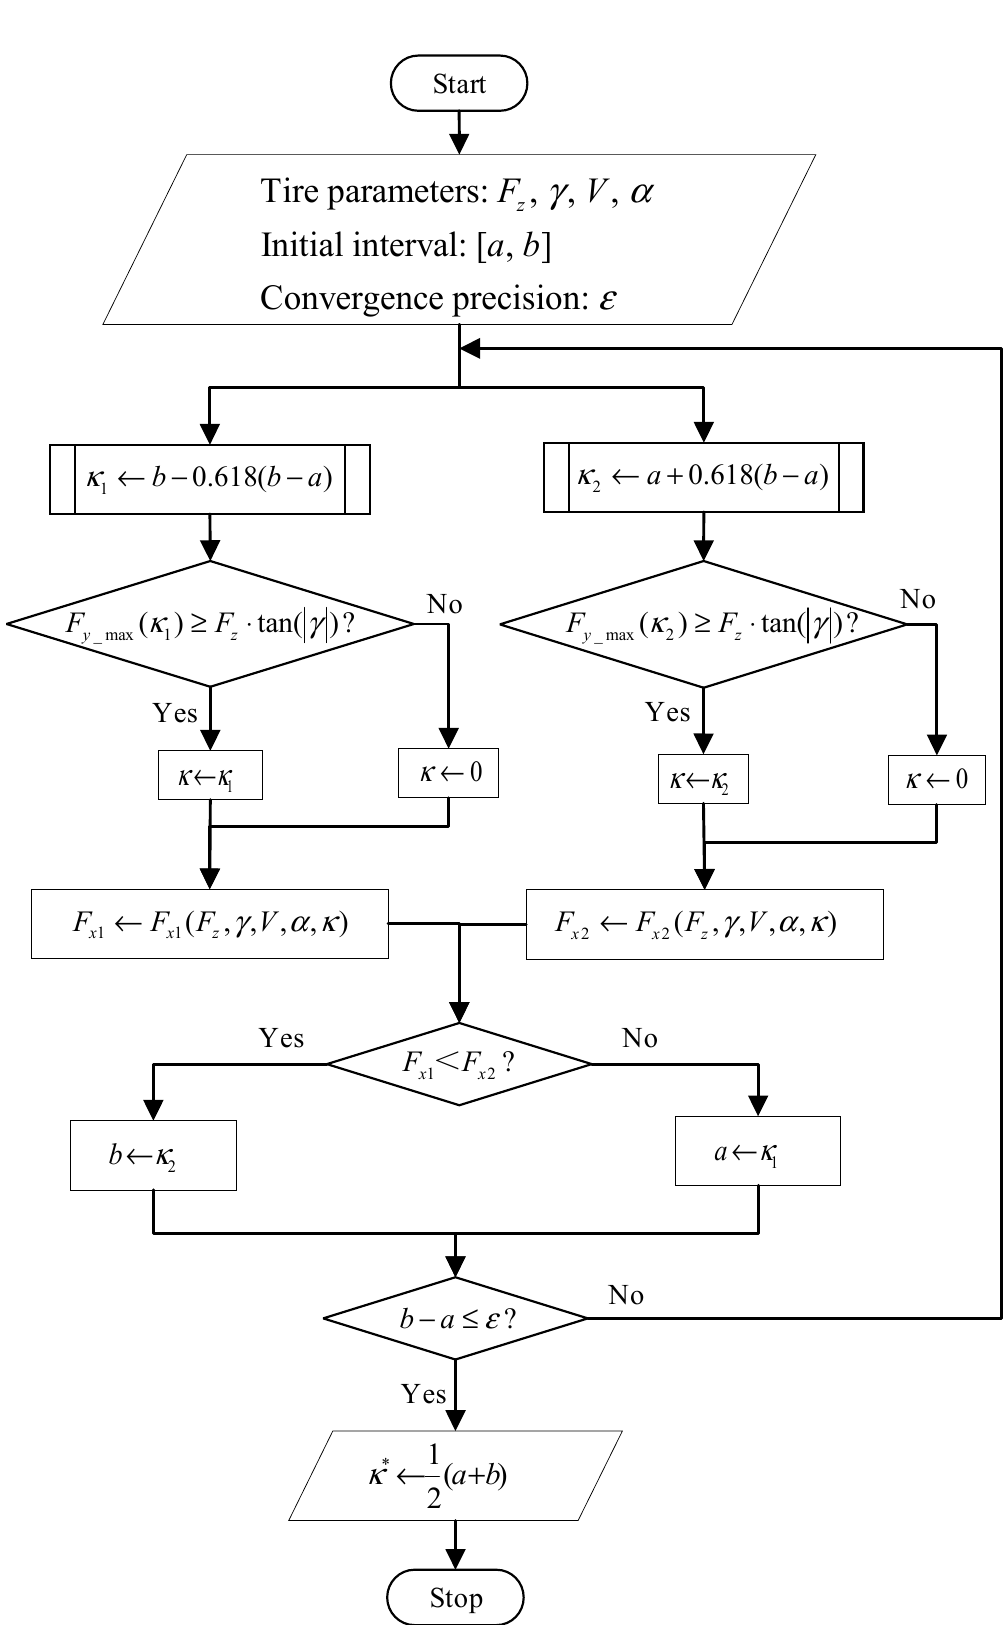
Figure 7. Algorithm flow chart for the optimal slip ratio